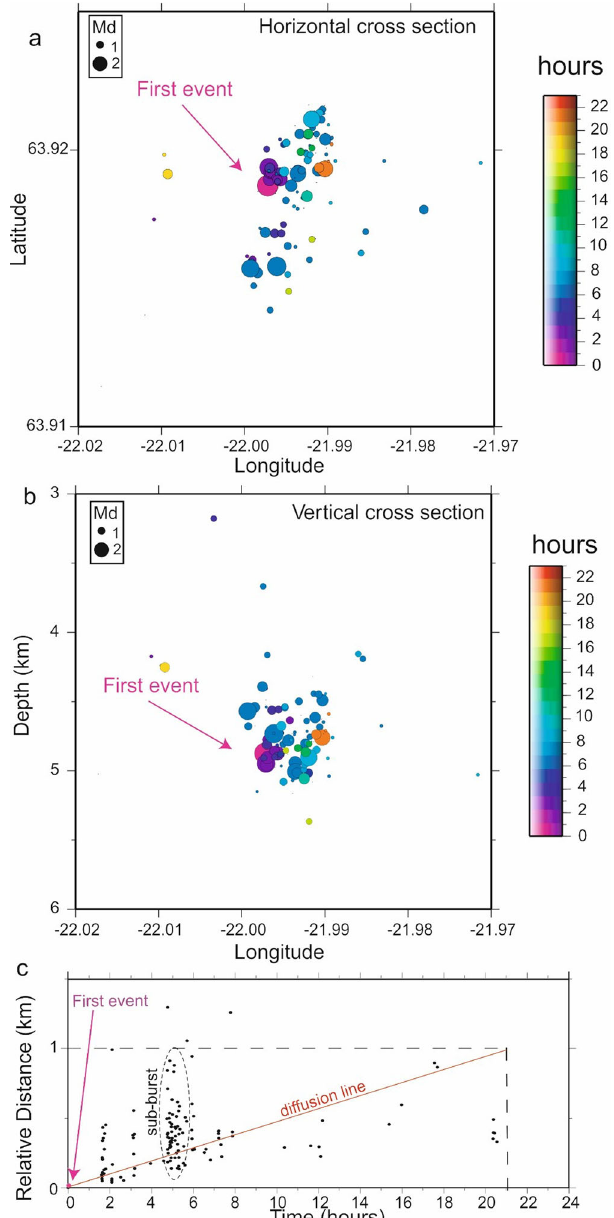
Fig. 5 Space – time evolution of hypocenters of a seismic swarm occurring on June 22, 2005, beneath Lake Kleifarvatn. a Map view, b EW vertical cross section, and c relative distance to the fi rst event versus time.